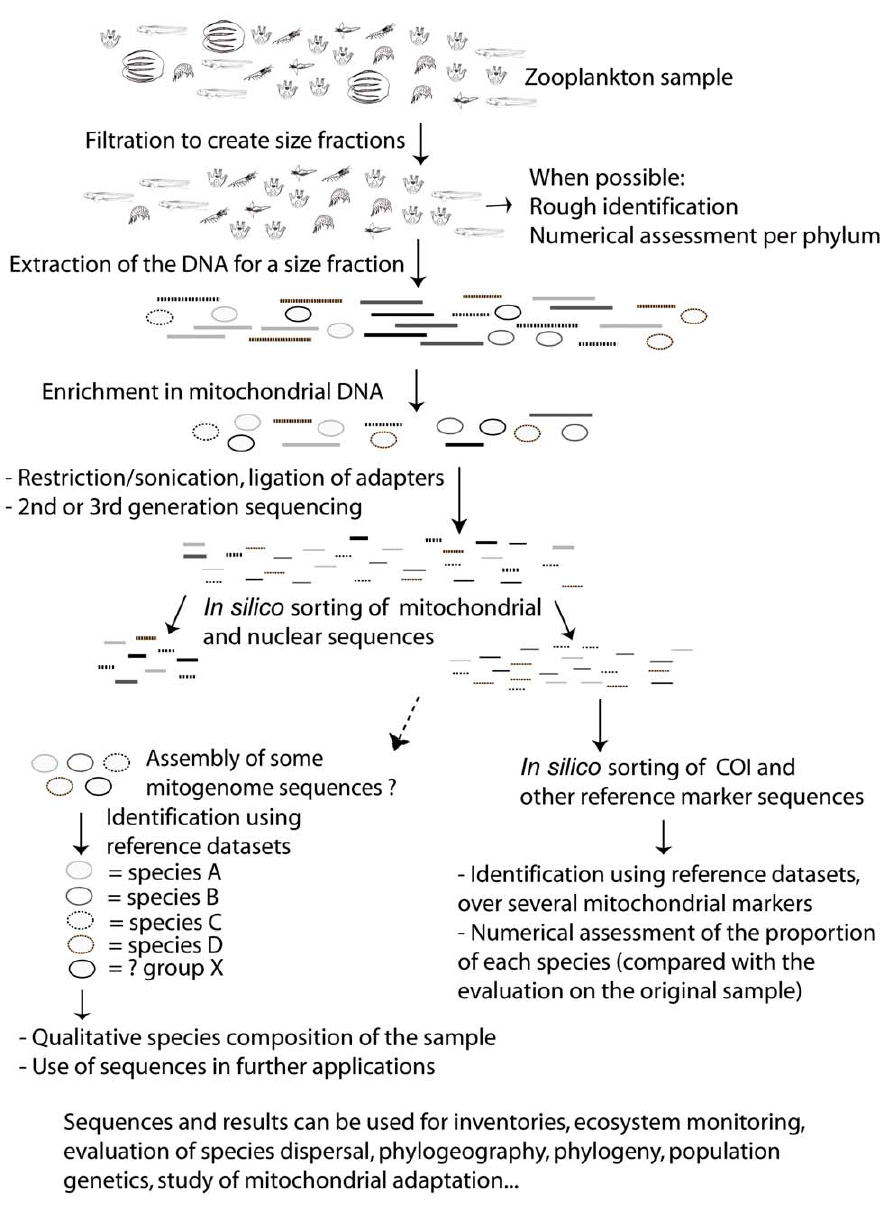
Figure 7. Summary of the approach for complex samples of unknown content (for instance zooplankton). For complex samples, the most valuable part of the approach is the isolation of mitogenomic DNA based on its properties, precluding PCR biases. This is followed by a cluster analysis on multiple mitochondrial markers. Complete mitogenome reconstruction might be possible only in some limited cases, as there might be a mix of closely related species in the sample.